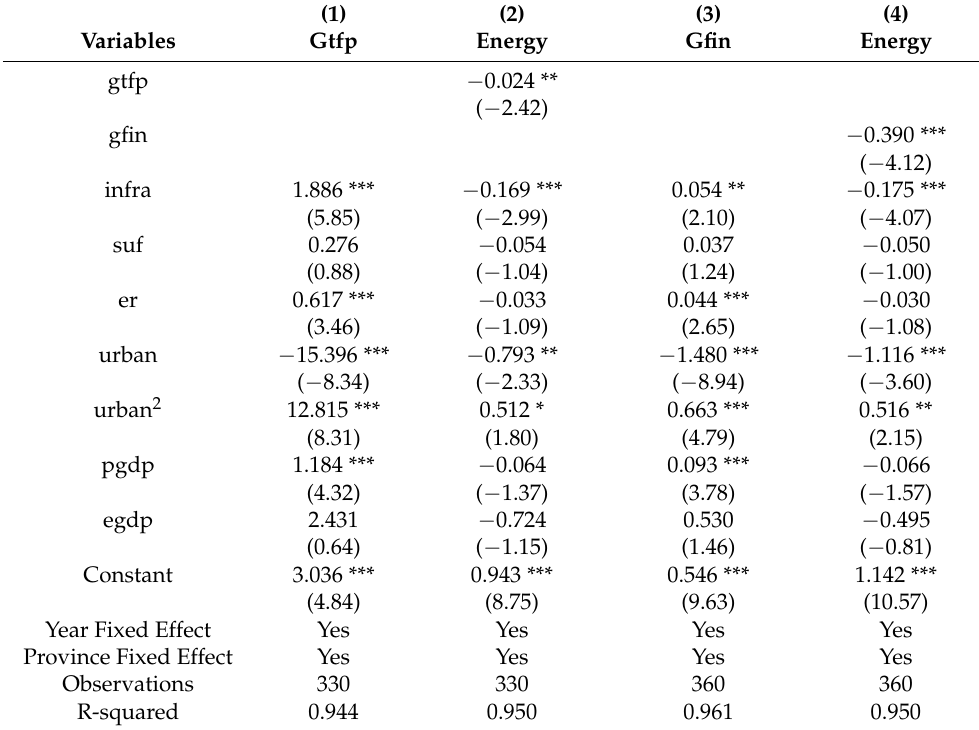
Table 6. Mechanism